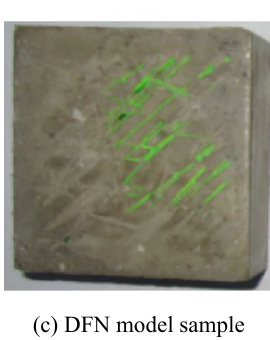
Fig. 4 Prefabrication process of the DFN model sample (Wang et